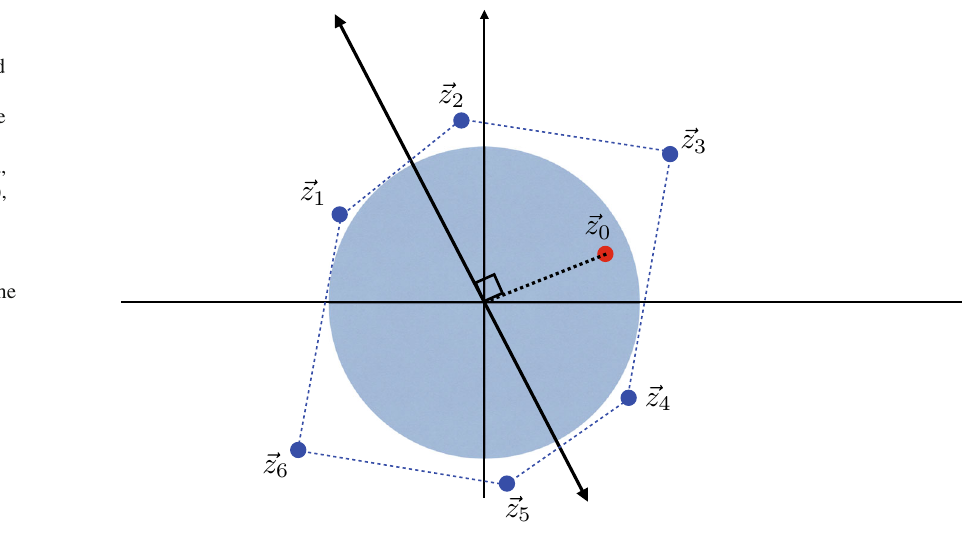
Fig. 3 Preservation of